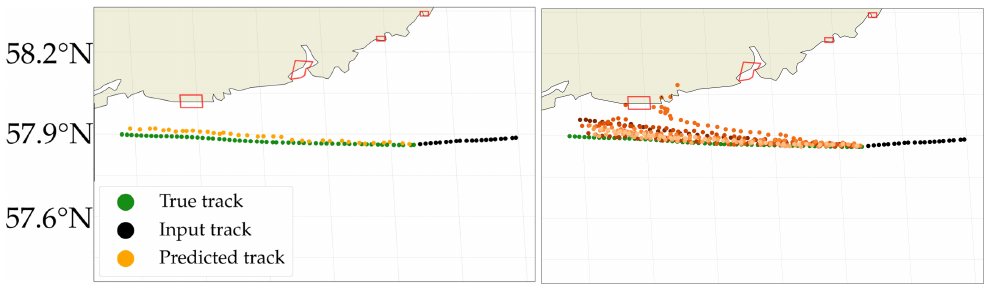
Figure 5. Predictions made with the BLSTM-MDN model. ( left ): A simple cargo vessel trajectory with input samples shown in black, true future trajectory in green and the predicted trajectory in orange. Harbours are illustrated as red polygons with the harbour of Mendal being the leftmost polygon. The model can satisfactorily predict simple trajectories. ( right ): 10 different sampled predictions 36 times steps into the future (3 h), shown in a shade of orange. The predictions mostly follow the true track shown in green, with one future trajectory heading to the harbour of